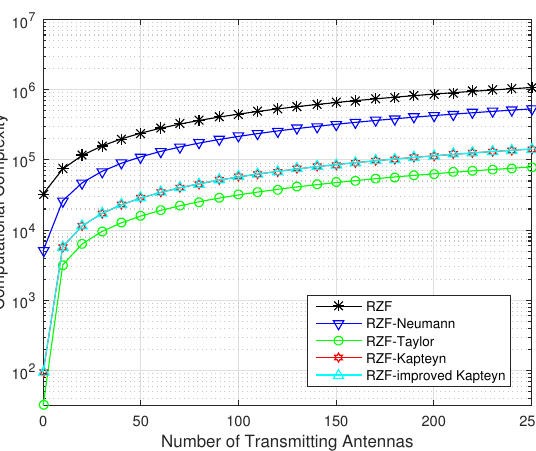
Figure 1. Computational complexity ( K = 32, N =